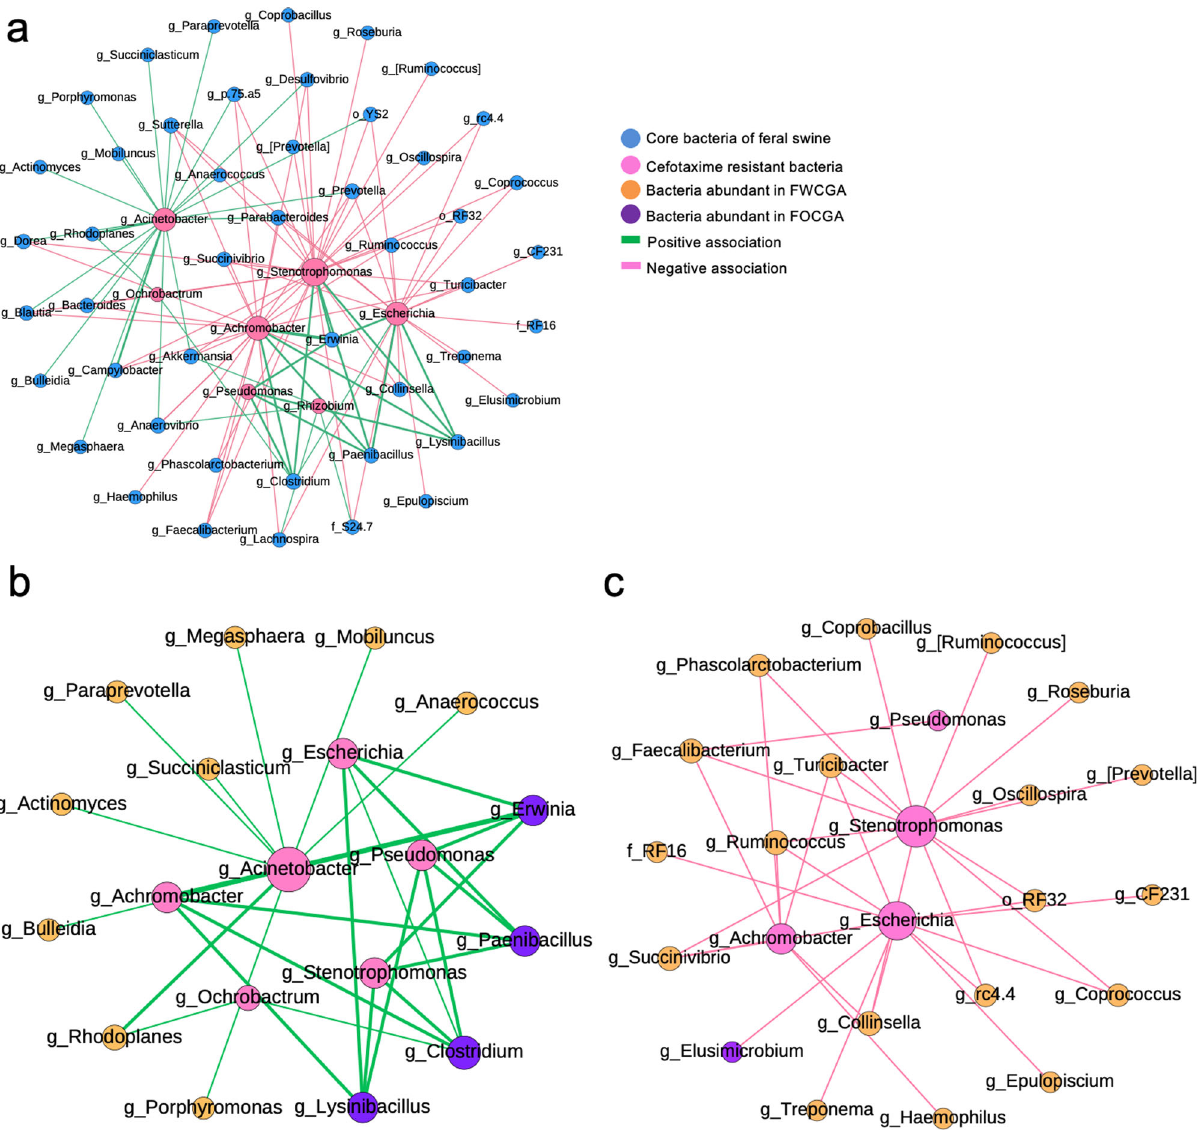
Fig. 8 Association between core-bacteria and cefotaxime resistant bacteria (CRB) in feral swine. a Co-occurrence bacterial network between core- bacteria of feral swine and major CRB genera. b Network analysis showing positive associations between core-bacteria of feral swine and CRB. c Network analysis showing negative associations between core-bacteria of feral swine and CRB. Each pair of correlations has P -value < 0.05 and correlation coef fi cients above 0.2. Node size indicates the number of connections between taxa and thickness of the lines indicates the strength of